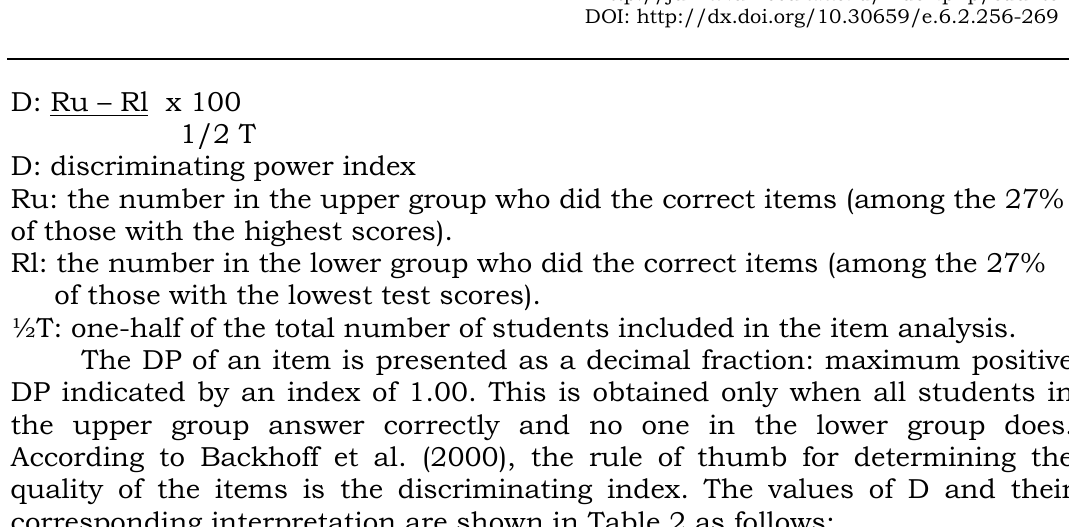
Table 2. Discriminating power of the answers according to their D value D = Quality Recommendation >